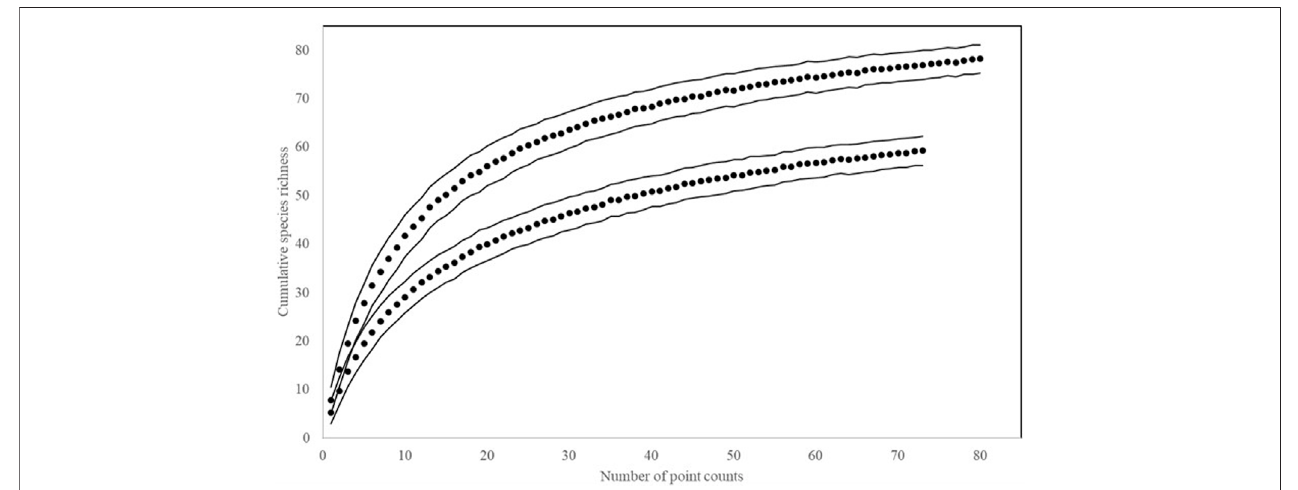
FIGURE3| Speciesaccumulationplotsfor pointcount surveys atBinyo-Penyilam (2006and 2019). Linesrepresent standarddeviation.Per pointrichness (S)and diversity (H ′ ) ± ( s ) 2006: S = 5.6 ± 2.6, H ’ = 1.5 ± 0.5; 2019: S = 7.7 ± 2.7, H ’ = 1.9 ± 0.4.